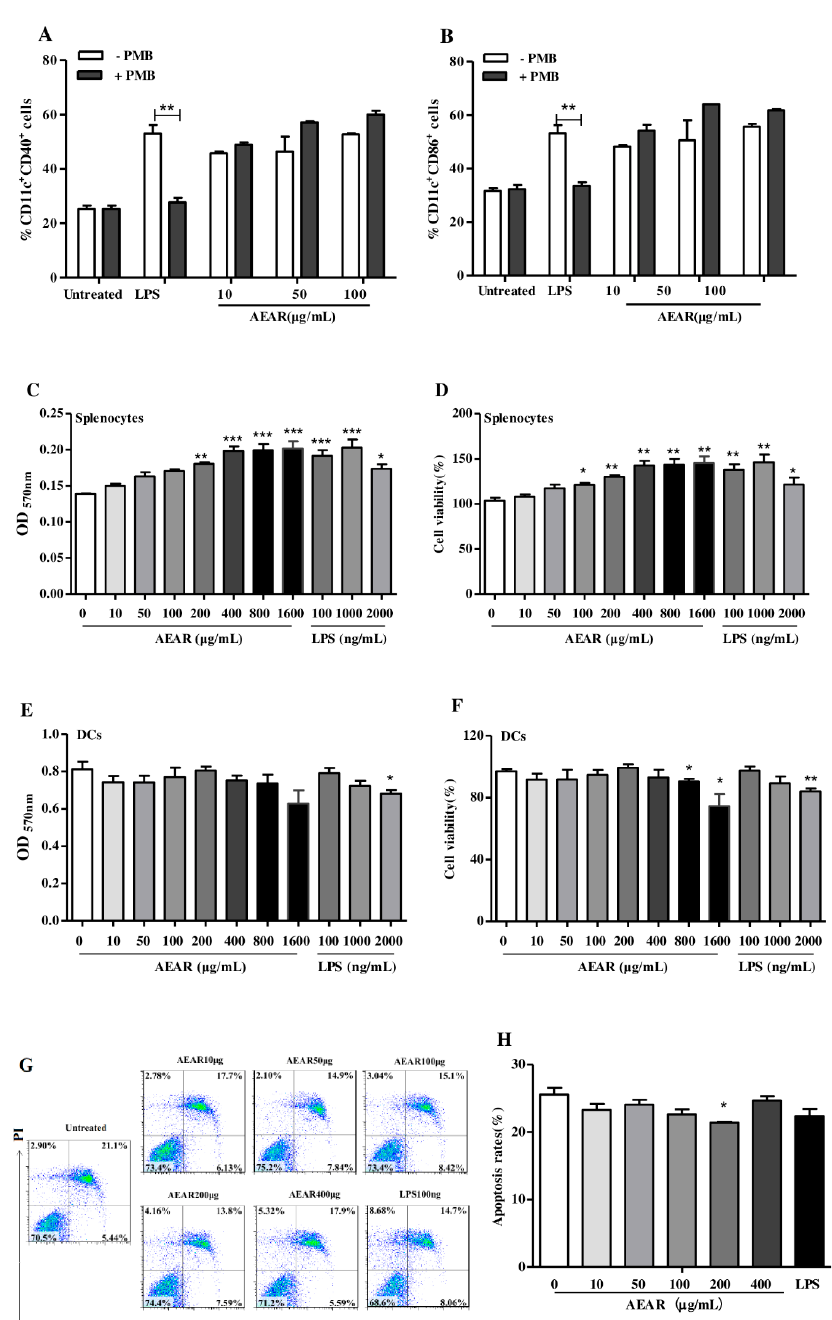
Figure 2. E ff ects of AEAR on the viability. ( A , B ) BM-dendritic cells (DCs) were induced under the existence of GM-CSF for 6 days and AEAR (10, 50, and 100 µ g / mL) or LPS (100 ng / mL) were pretreated with or without PMB (100 µ g / mL) for 1 h, and then used to stimulate DCs (1 × 10 6 per 1 mL);